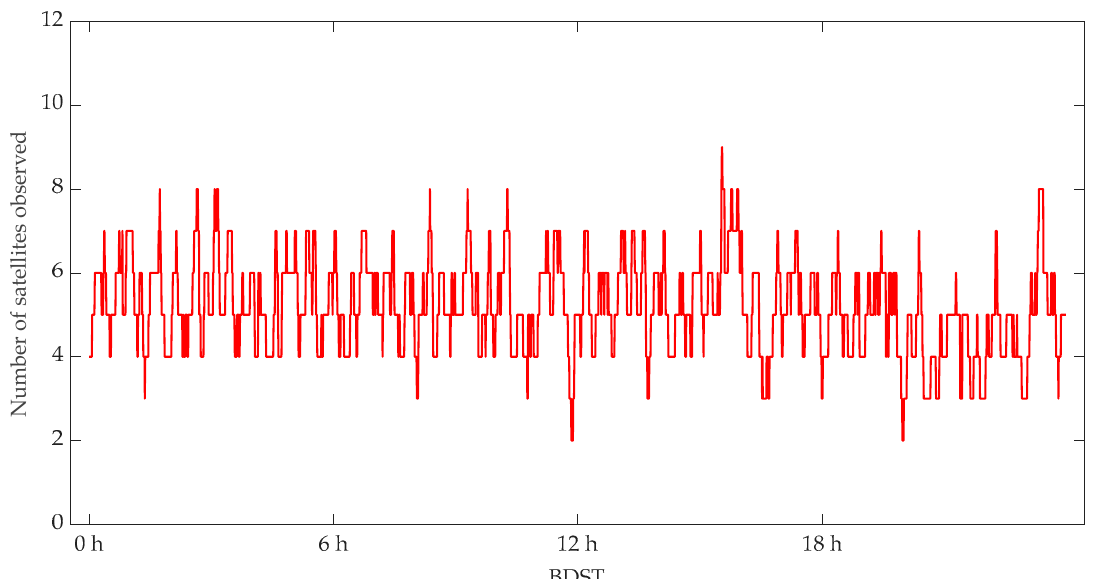
Figure 2. Number of BDS satellites observed on 10 July 2021.